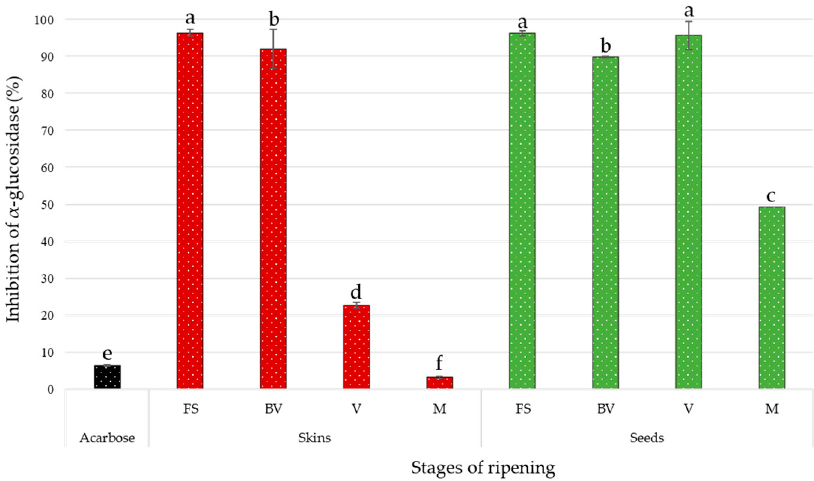
Figure 2. Inhibitory effects of Tannat skin and seed extracts (0.4 g/L) and positive control (acarbose at 0.4 g/L) on α -glucosidase (pH 6.8, T = 37 °C) at different stages of ripening: First Stage (FS), Before Veraison (BV), Veraison (V) and Maturity (M). Values are means of four replicates. Significant differences between treatments at p < 0.05 are indicated with letters as measured by Tukey test.